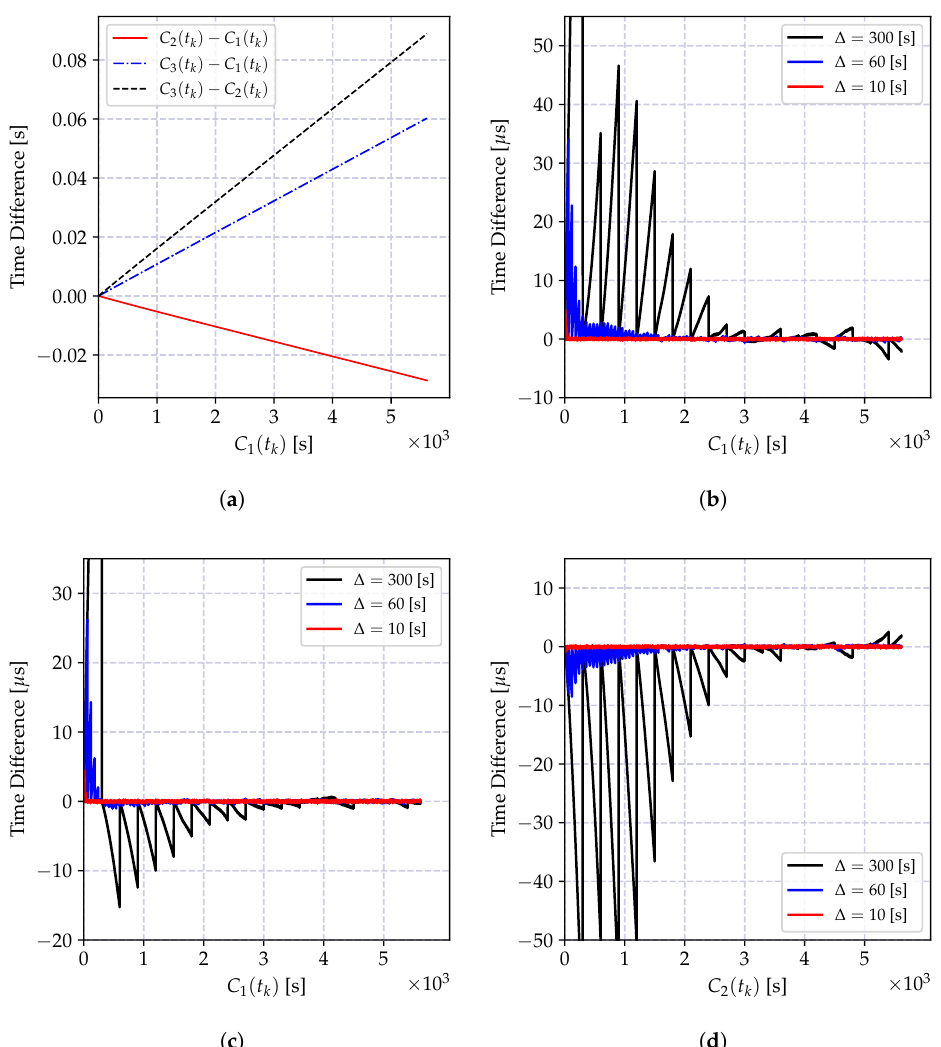
Figure 21. The results for the time data acquired using three IEEE 802.15.4-2006 compliant radios. In ( a ), the variation of time difference with the transmitter node’s time. In ( b – d ), the time difference in microseconds between the local clock time reports and the reference clock reports when the time relation parameters of the incremental time model are estimated at different periods ∆ using an exponentially weighted recursive estimator in Equation (39a–c) with weight λ = 0.4. The time differences between C 2 ( t k ) and C 1 ( t k ) , C 3 ( t k ) and C 1 ( t k ) , and C 3 ( t k ) and C 2 ( t k ) after compensation are shown in respective